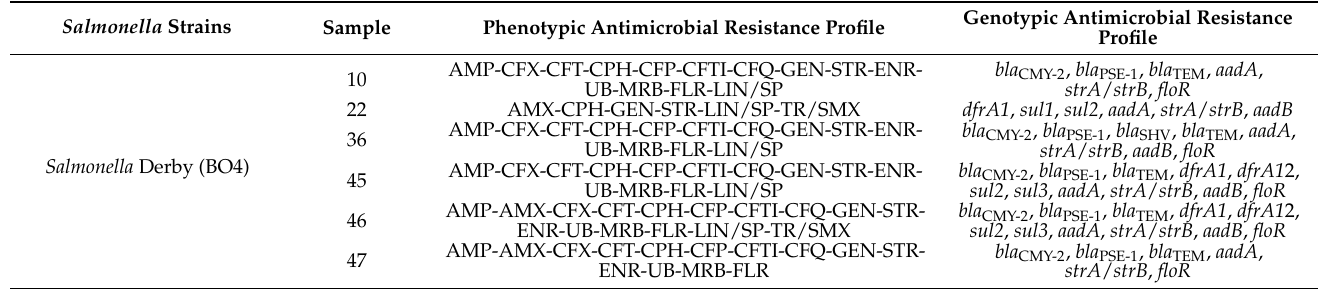
Table 3. Distribution of resistance genes in relation to antimicrobial resistance